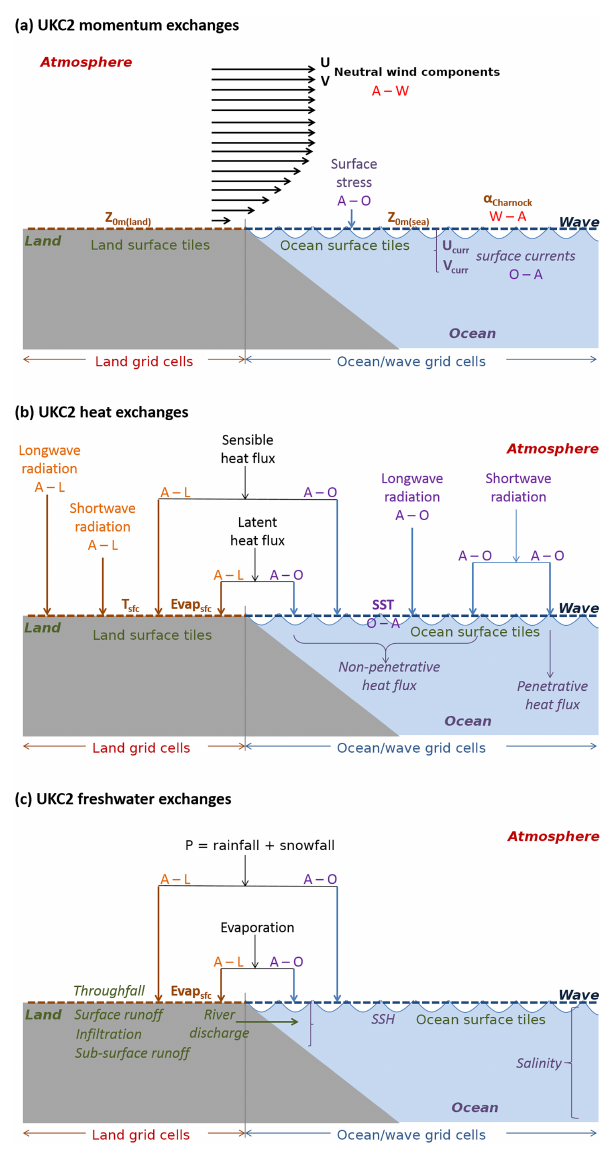
Figure 2. Summary of time-averaged fields exchanged each hour in the UKC2 coupled simulation categorized as (a) momentum, (b) heat and (c) freshwater exchanges between atmosphere–land (UM-JULES), ocean (NEMO) and wave (WAVEWATCH III) com- ponents. The relevant bulk and flux variables listed in Table 1 are shown as being exchanged between components, with flux variables shown with